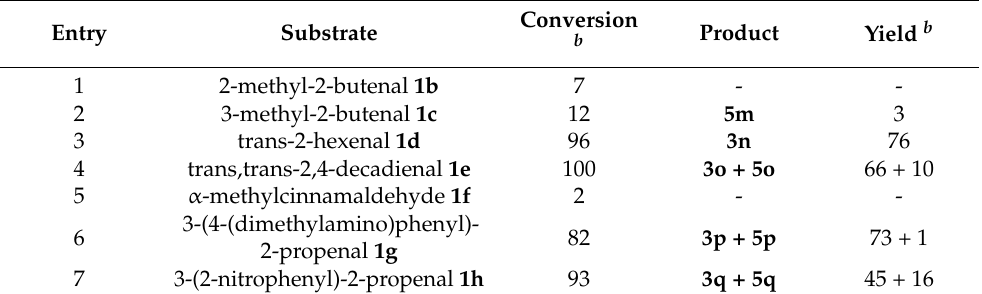
Table 3. Redox esterification of selected aldehydes with benzyl alcohol catalyzed by G 0 DippImI a . Entry